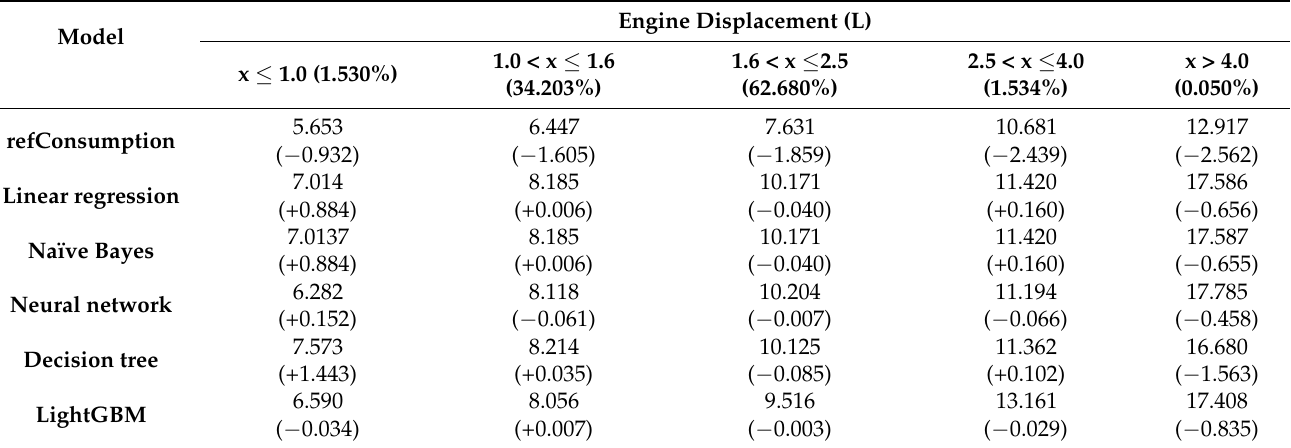
Table 7. Average fuel consumption results for each model by displacement